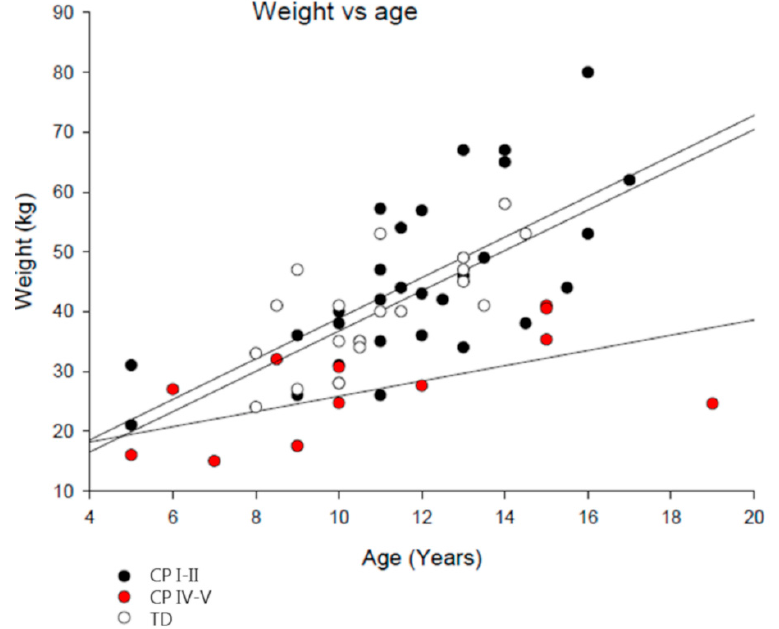
Figure 1. Scatter plot illustrating the relationship between age and body weight in TD children (n